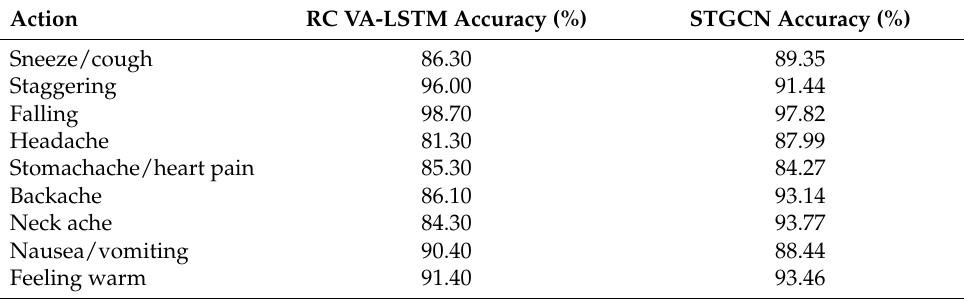
Table 7. Comparison of accuracy of medical condition-related